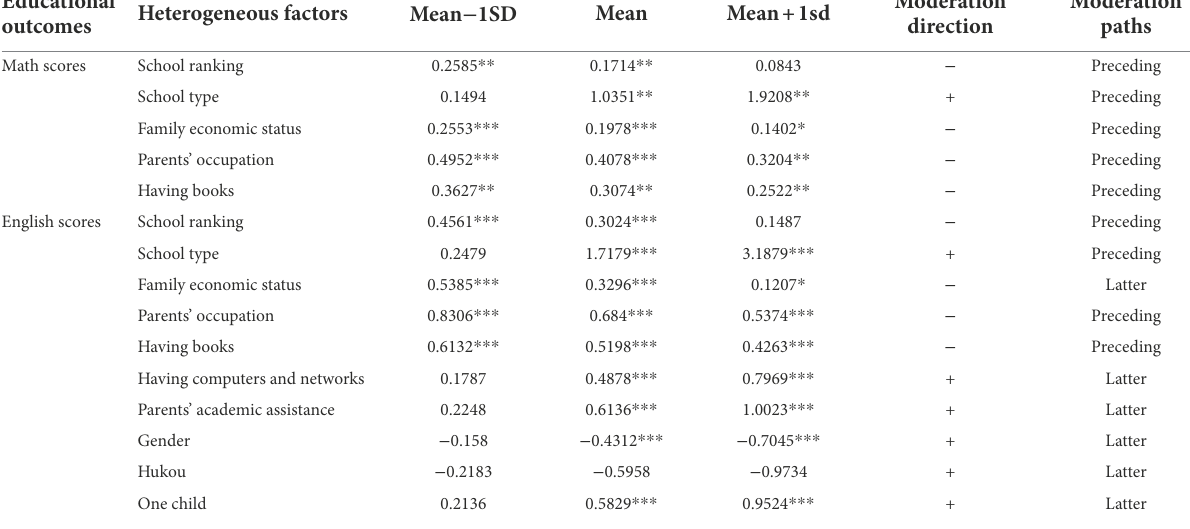
TABLE 8 The moderation effect of national education